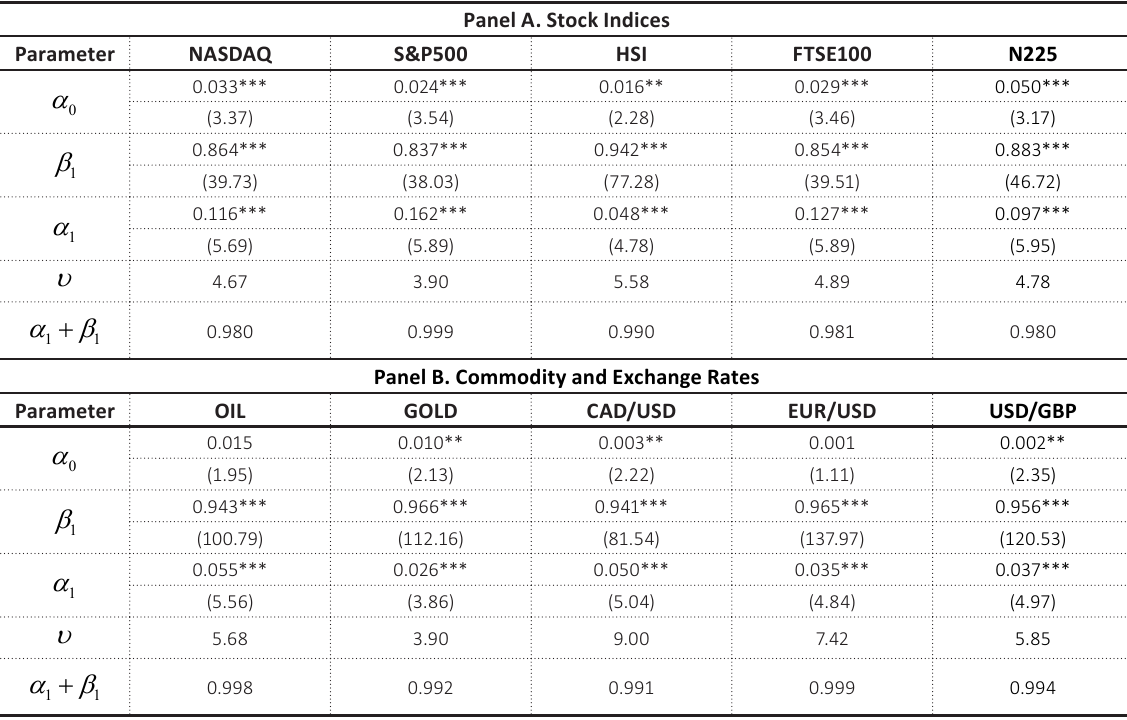
Table A2. Estimation of the GARCH(1,1)- t components in the F-MIDAS-Q model Panel A. Stock